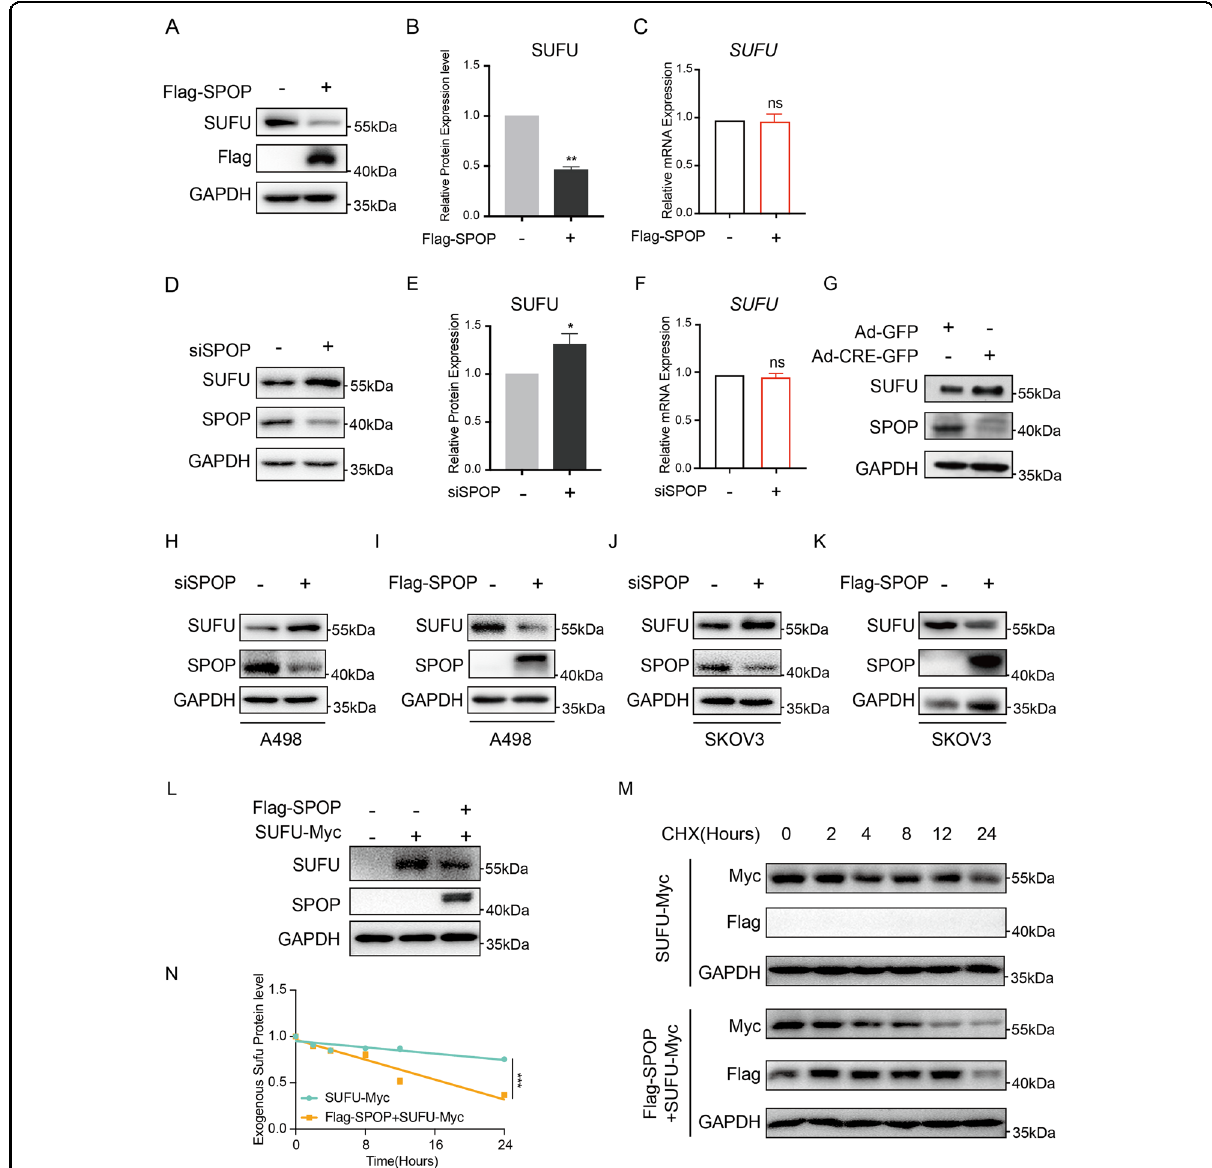
Fig. 1 SPOP negatively regulates SUFU in mammals. A – F After transfection of indicated plasmids or siRNAs into 293T cells, SPOP and SUFU levels were veri fi ed by western blotting and qRT-PCR, and the abundance of SUFU protein in A and D was quanti fi ed. G SUFU protein levels were detected by western blot analysis of SPOP foxl/ fl ox cells infected with Ad-Cre-GFP viruses in comparison with cells infected with Ad-GFP viruses. H – K Protein levels of SUFU were determined by western blot analysis of the kidney cancer cell line A498 and ovarian cancer cell line SKOV3 after indicated transfection. L SUFU-Myc protein levels were examined by western blot analysis of 293T cells which were transfected with Flag-SPOP. Western blot analysis M and quanti fi cation N showed stabilization of SUFU-Myc in 293T cells transfected with RK5-Flag-SPOP. Protein synthesis was blocked with cycloheximide (CHX) treatment. The error bars indicate SD. * P < 0.05; ** P < 0.01; *** P < 0.001; ns not signi fi cant (unpaired Student ’ s t